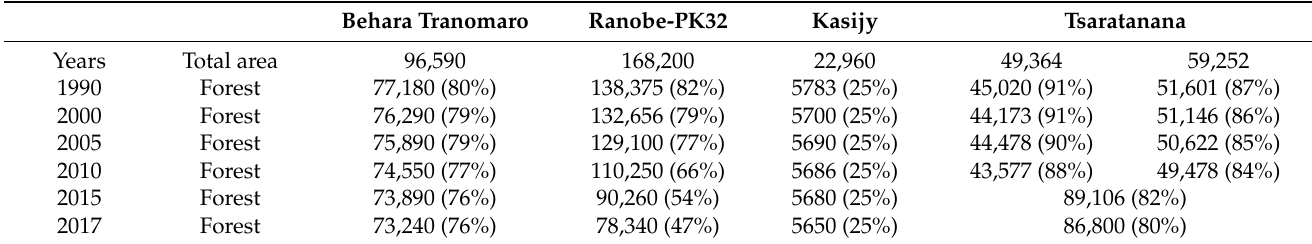
Table 2. Forest cover for the six years of analysis of the four case study sites. (Numbers are in hectares as used in our